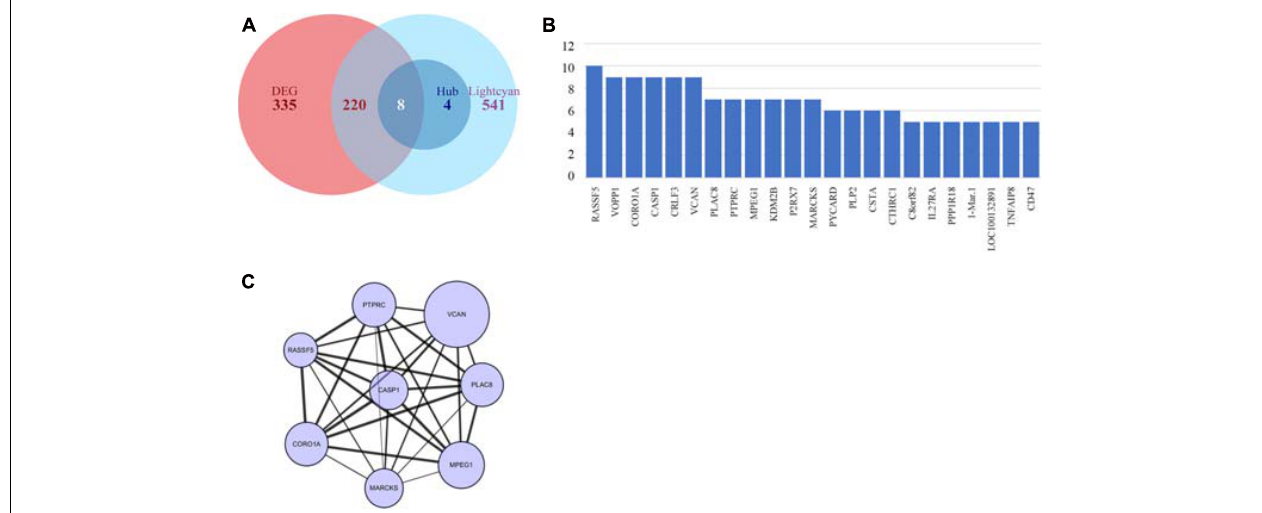
FIGURE 4 | Identification of key genes by intersecting DEGs and hub genes. (A) Venn plot of DEGs and hub genes. (B) Hub genes identified using cyto-hubba. (C) Interaction of intersect genes using cytoscape.